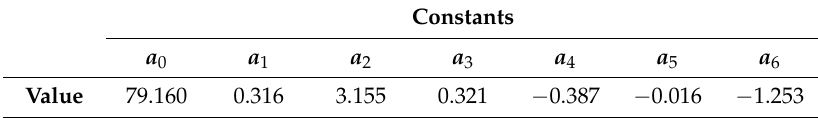
Table 4. Fitted constants for multiple linear regression of estimated force of B